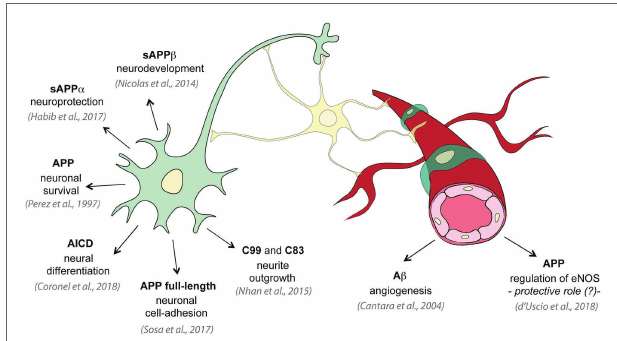
FIGURE 2 | Physiological roles of APP and its metabolites. Several studies investigated the physiological functions of APP on neural tissue: APP promotes neuron viability and axonogenesis (Perez et al., 1997); membrane APP full-length protein shows cell-adhesive properties in neurons (Sosa et al., 2017); sAPP α has been shown to be neuroprotective and to have neuronal trophic properties (Habib et al., 2017); sAPP β is important for neuronal development (Nicolas and Hassan, 2014); C99 and C83 fragments are involved in neurite outgrowth (Nhan et al., 2015); AICD controls neural differentiation (Coronel et al., 2018). On the contrary only few studies investigated the physiological role of APP in vascular tissue: low concentrations of A β promote endothelial cells migration and proliferation and angiogenesis (Cantara et al., 2004); and APP regulates expression of endothelial nitric oxide synthase (eNOS) and may exert a protective role (d’Uscio et al.,